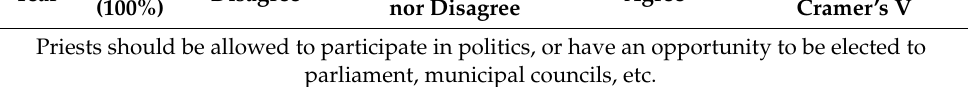
Table 2. Anti-clergy sentiments shift during a short-term period (2012–2018) in Lithuania. N Year